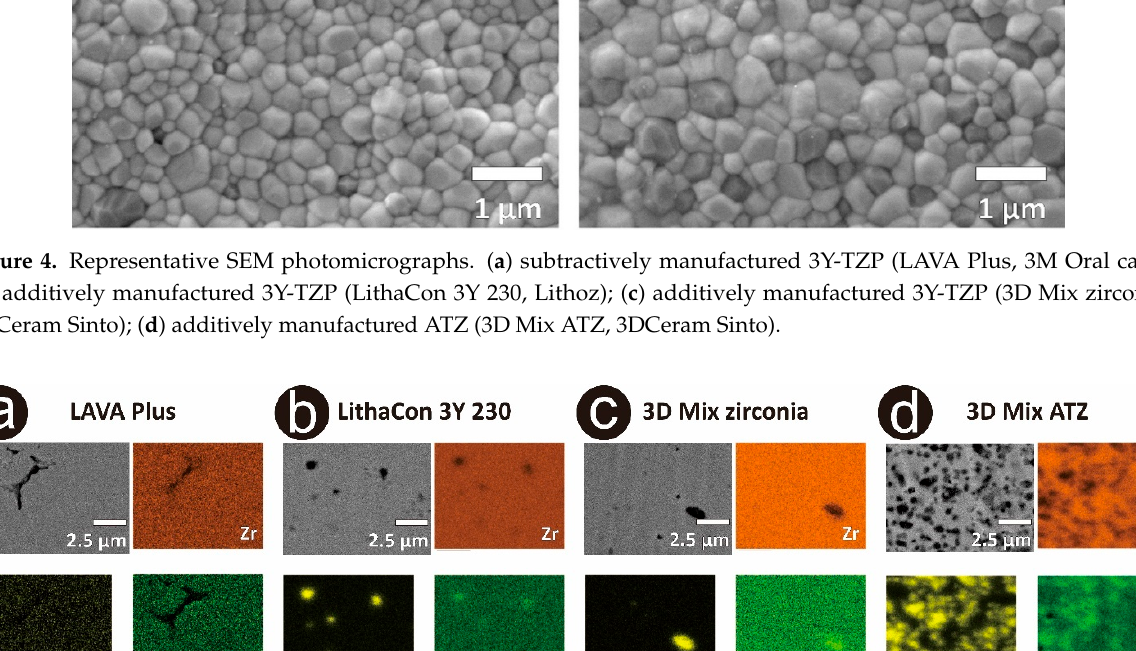
TZP (LAVA Plus, 3M Oral Care); ( b ) additively manufactured 3Y-TZP (LithaCon 3Y 230, Lithoz); ( c ) additively manufactured 3Y-TZP (3D Mix zirconia, 3DCeram Sinto); ( d ) additively manufactured zirconia (3D Mix ATZ, 3DCeram Sinto).